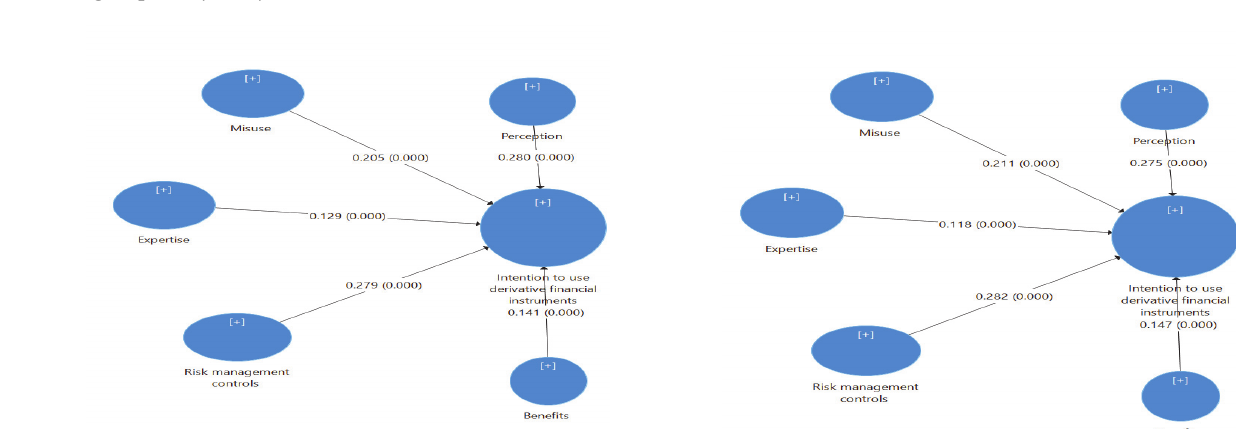
Fig. 6. Results of multi-group analysis with group of university and post-graduate